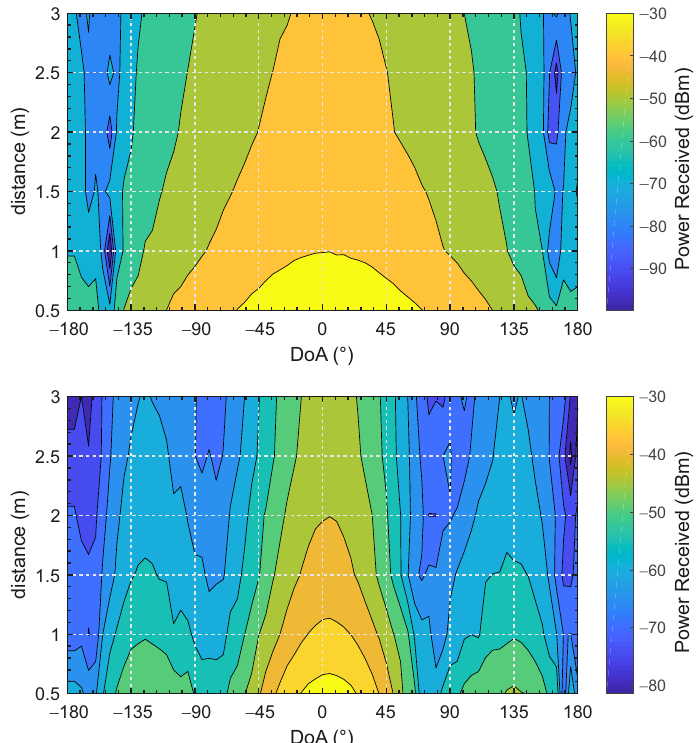
Figure 7. Power distribution relative to antenna #1 in the unperturbed case, at 2.45 GHz ( top ) and 5.2 GHz ( bottom